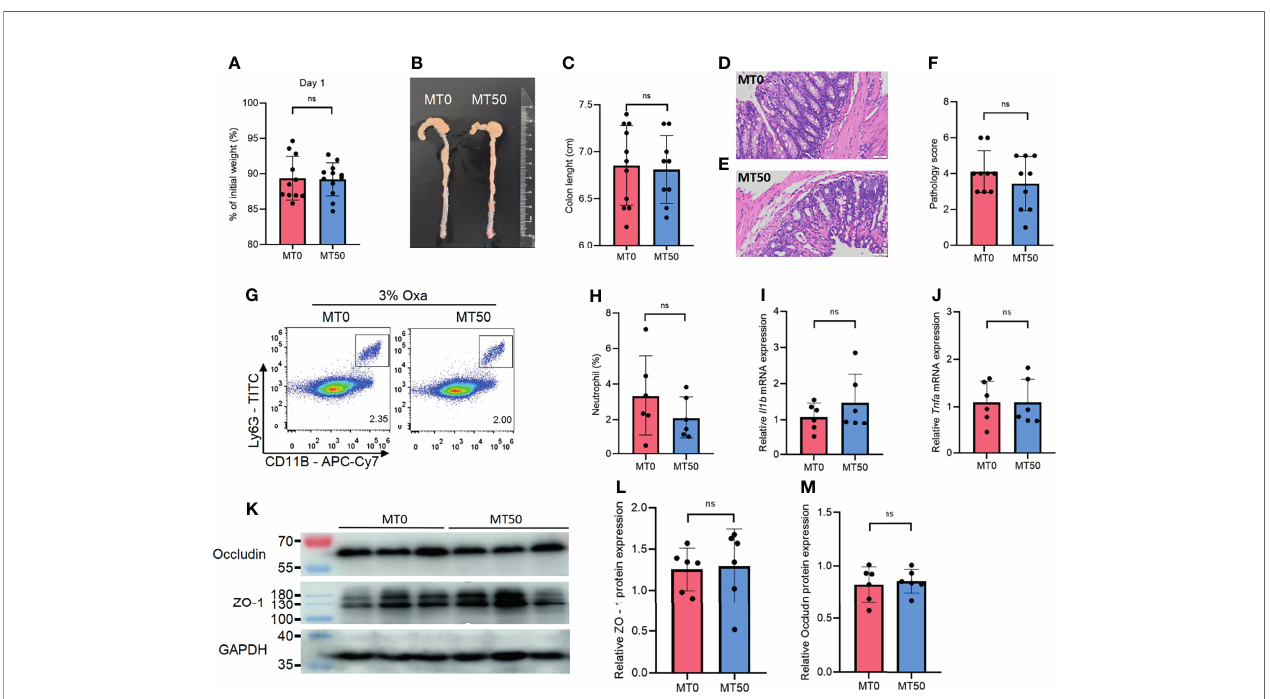
FIGURE 4 | Effect of melatonin on oxazolone (Oxa)-induced colitis depends on gut microbiota. (A) Weight changes and colon length (B, C) in co-housed mice at day 1 after 3% oxazolone enema. (D – F) Representative H&E staining of colonic sections (×20) and pathological score of in fl amed colonic tissue. (G, H) Flow cytometry analysis of colonic CD45 + CD11b + Ly6G + neutrophil subsets in co-housed mice at day 1 after 3% oxazolone enema. (I, J) qPCR of Tnfa and Il-1b mRNA in colonic tissues in co-housed mice at day 1 after 3% oxazolone enema (all values were normalized to the melatonin-untreated group). (K – M) Immunoblot and densitometric analysis of ZO-1 and occludin in co-housed mice. Data are representative of at least two independent experiments. Data are shown as mean ± SD. ns, no signi fi